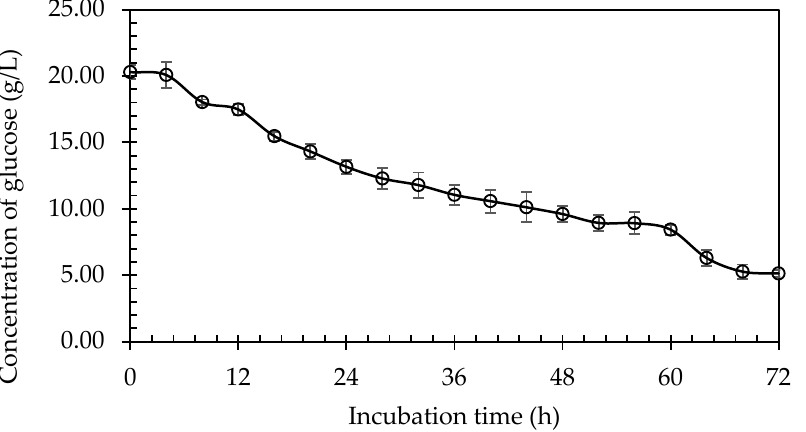
Figure 5. Glucose consumption of B. subtilis ATCC 6051 using pineapple plant stem hydrolysate as carbon source. Symbol represents: ○ : glucose. Error bars indicate the mean value ± standard deviation of triplicates of the sample.